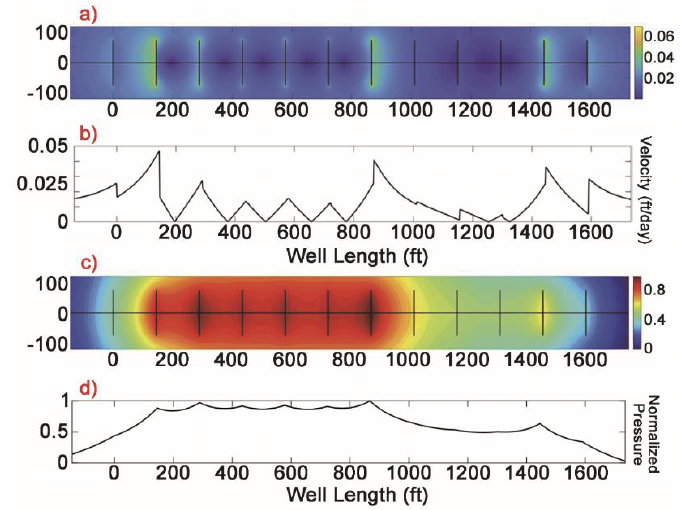
Figure 4. CAM model. (a) Map view of velocity magnitude contours (ft/day) (b) Vertical velocities measured at y = 0. (c) Map view of normalized pressured depletion contours. (d) Vertical profile of pressure magnitude variations along the well at y = 0 [18]. (Reproduced with permission from SEG, 2020).